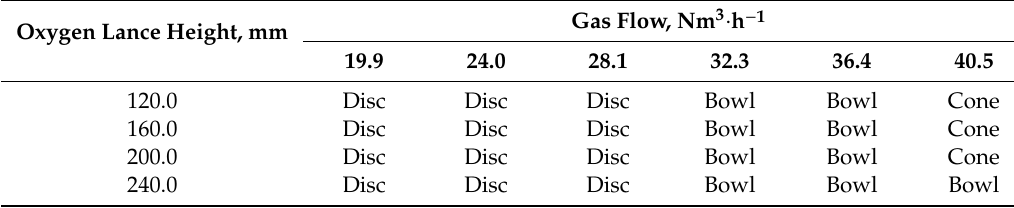
Table 3. Impact cavity shapes under the different top-blown gas jet conditions.